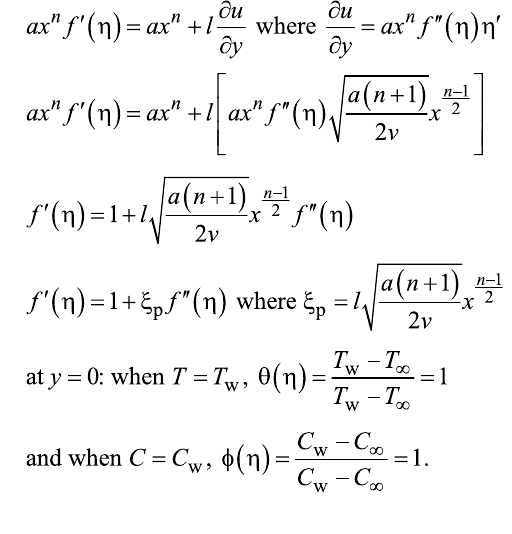
Solving a system of first-order differential equations The nonlinear and coupled partial differential equations, repre- sented by Equations 10–12, are solved by using the Adam’s predictor–corrector method which is the most efficient tech- nique in numerical analysis used to solve distinctive problems related to heat transfer, fluid mechanics, and electrical